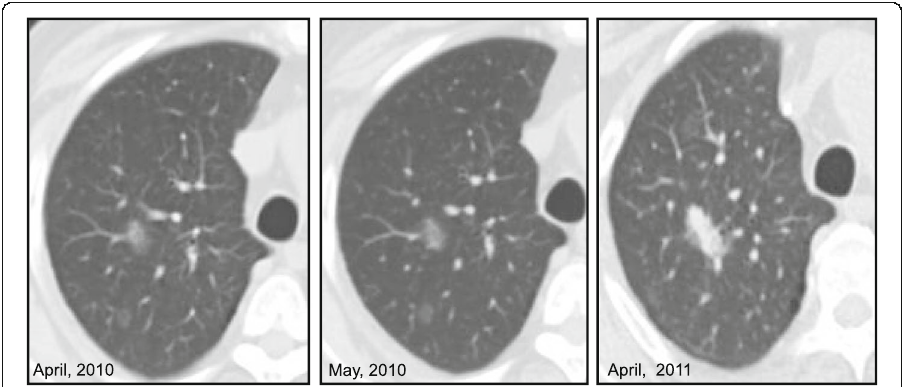
Fig. 3 A 69-year old man with colon-rectal cancer already treated in September 2008. In April 2010, CT scan showed, in right lung, two ground glass opacities in posterior segment of upper lobe. In May 2010, the nodules were stable on CT imaging. After 12-months (April, 2011), one ground glass opacity disappeared, while the other became a solid nodule. The final histological diagnosis was metastasis from lung